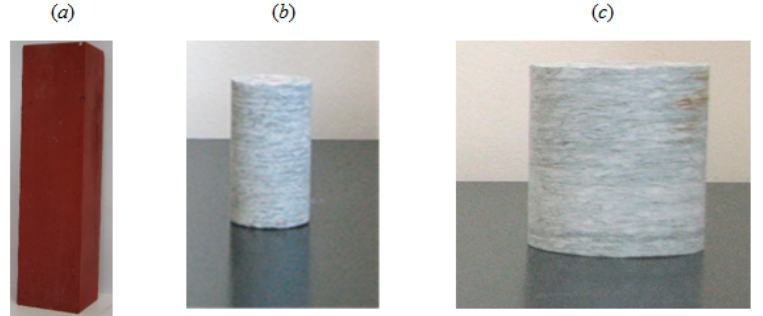
Figure 2. Blocks of cement mortar ( a ) and rods of Luserna stone ( b , c ).